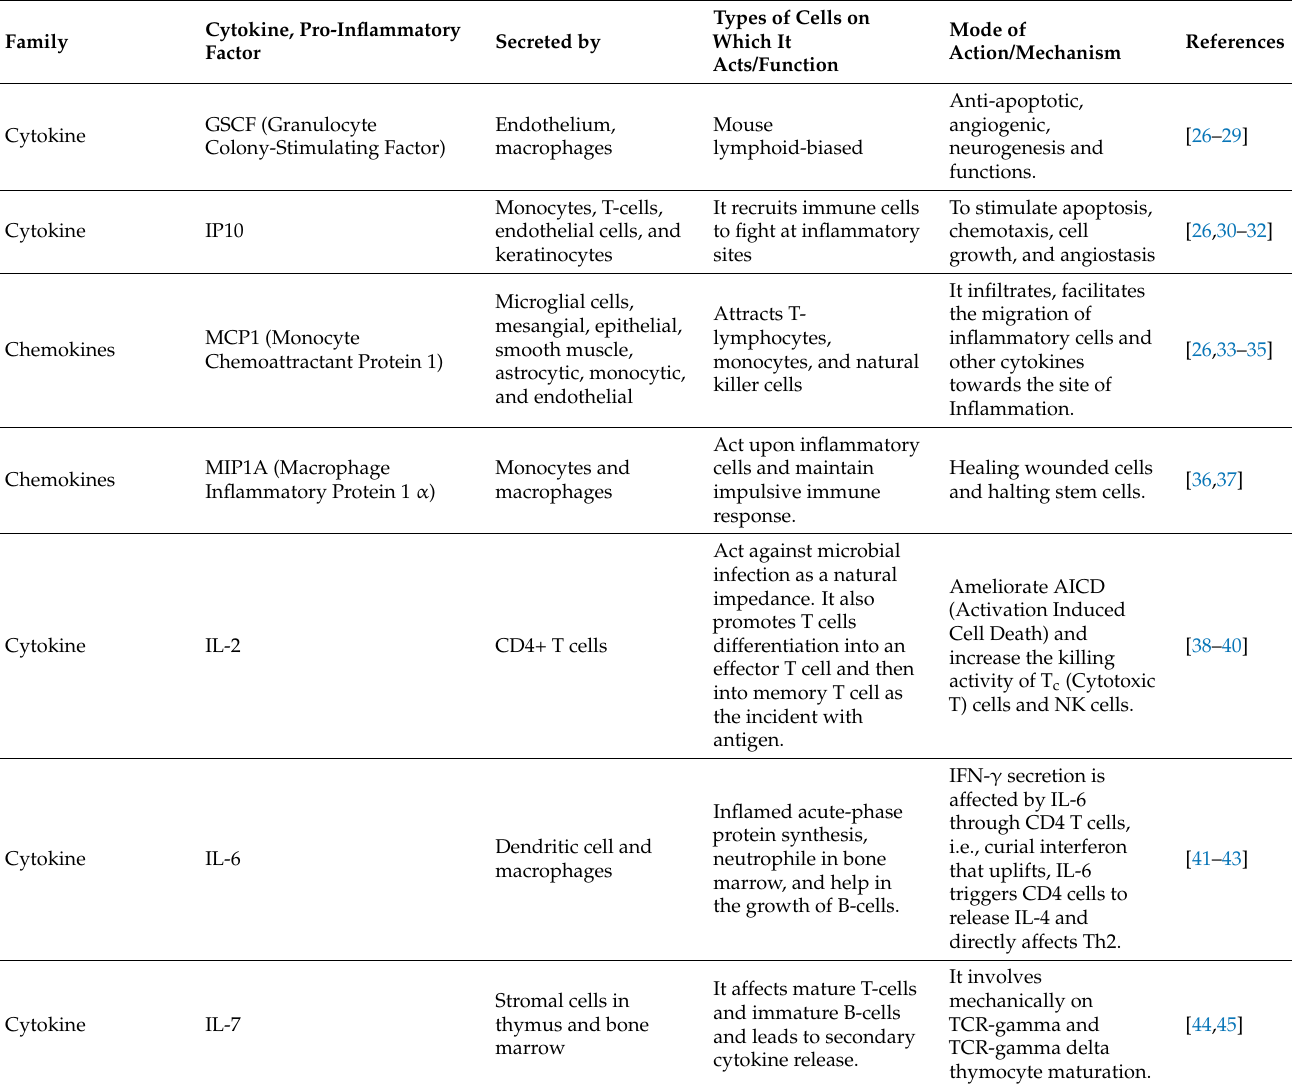
Table 1. Cytokines, their secretary cells, and mode of